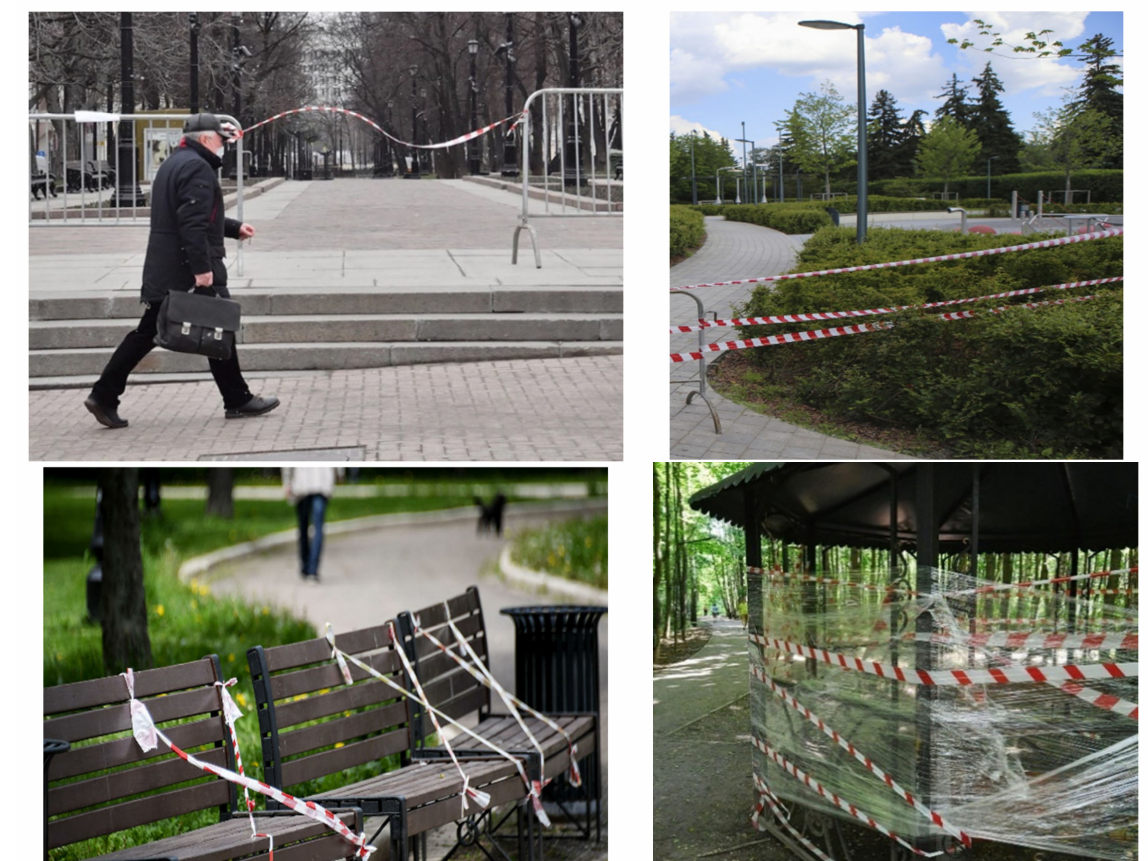
Figure 11. Closure of urban parks due to COVID-19 restrictions.